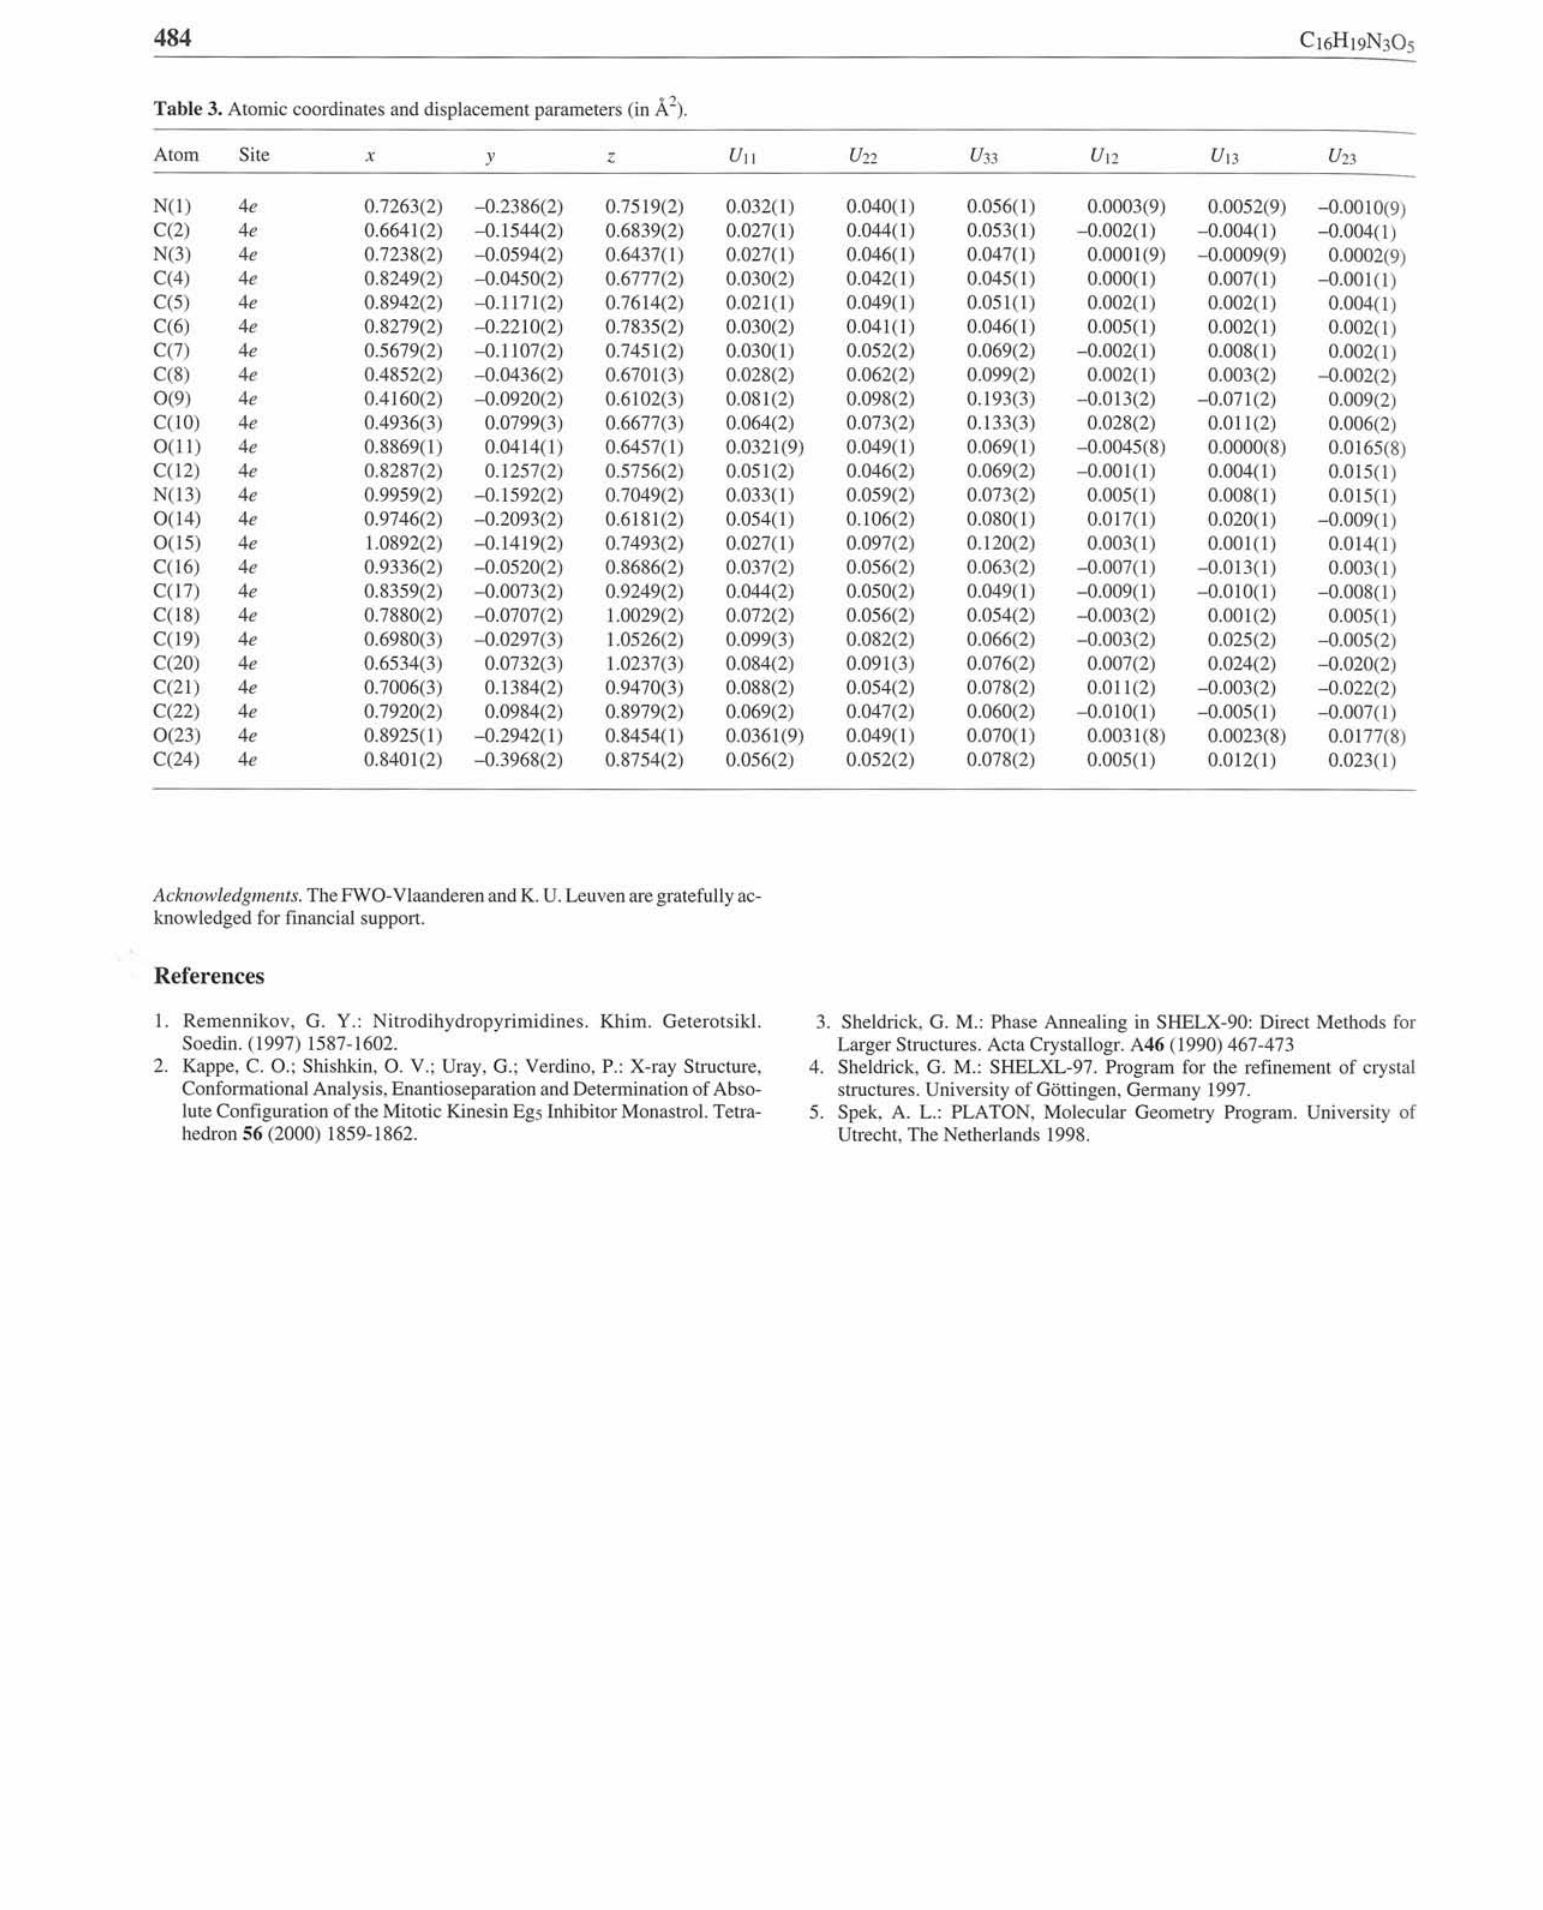
Table 3. Atomic coordinates and displacement parameters (in À 1